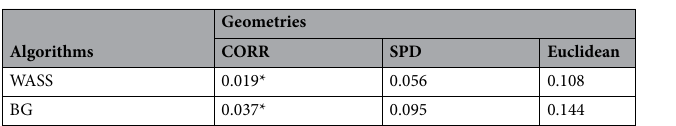
Table 3. Empirical p values on two classes of correlation matrices obtained from the Wasserstein (WASS) and Biswas–Ghosh (BG)-based permutation tests under three geometries. Numeric values with an asterick * indicate the null hypothesis of equal distributions is rejected at the significance level of 5%